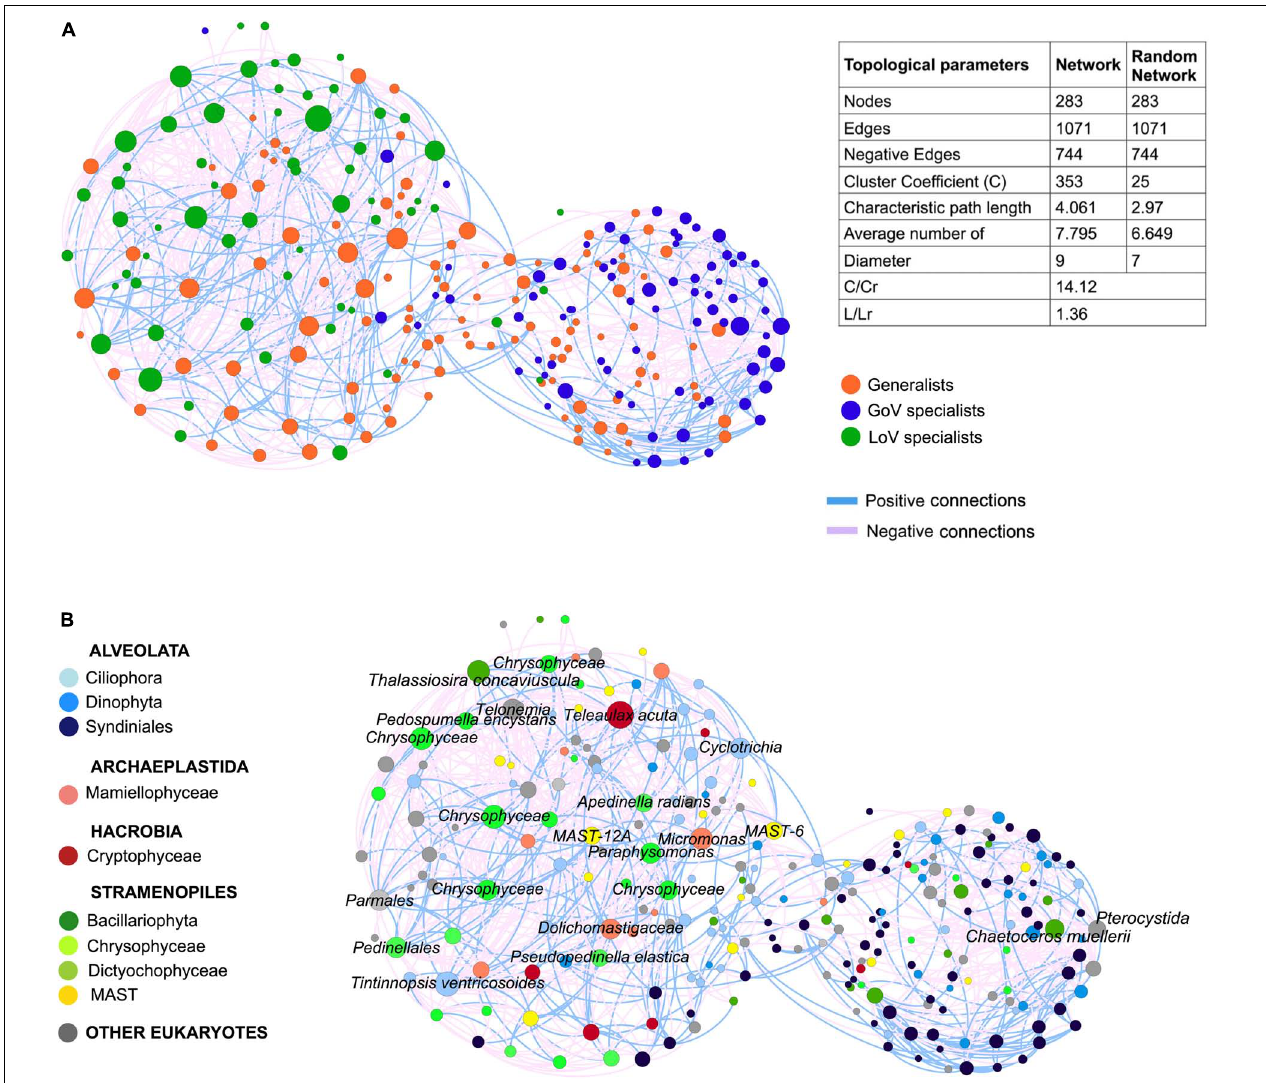
FIGURE 7 | Network of the normalized dataset (28 samples, OTUs > 50 reads) based on MIC-MINE algorithm. The size of nodes corresponds to the degree value (i.e., number of connections): (A) Network annotation (color of nodes) based on clam test prediction (generalists and specialists) and table of statistics for original and random network (C, clustering coefficient; L, characteristic path length; Cr, clustering coefficient of the random networks; Lr, characteristic path length of the random network); (B) Network annotation (color of nodes) based on the taxonomic affiliation and taxonomic details (name of nodes) for the 22